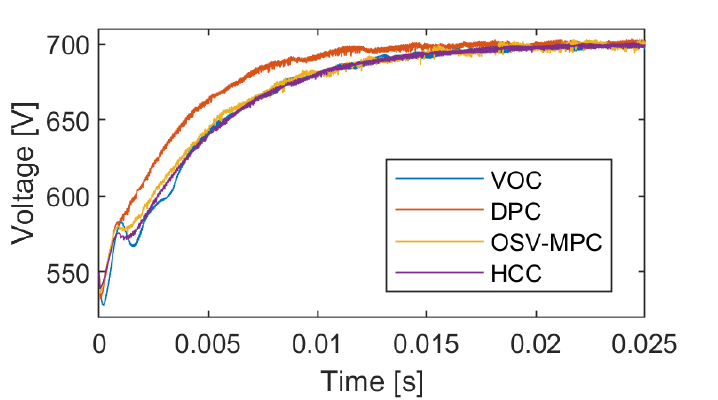
Figure 30. Start-up voltage transient of a pre-charged DC link with different control